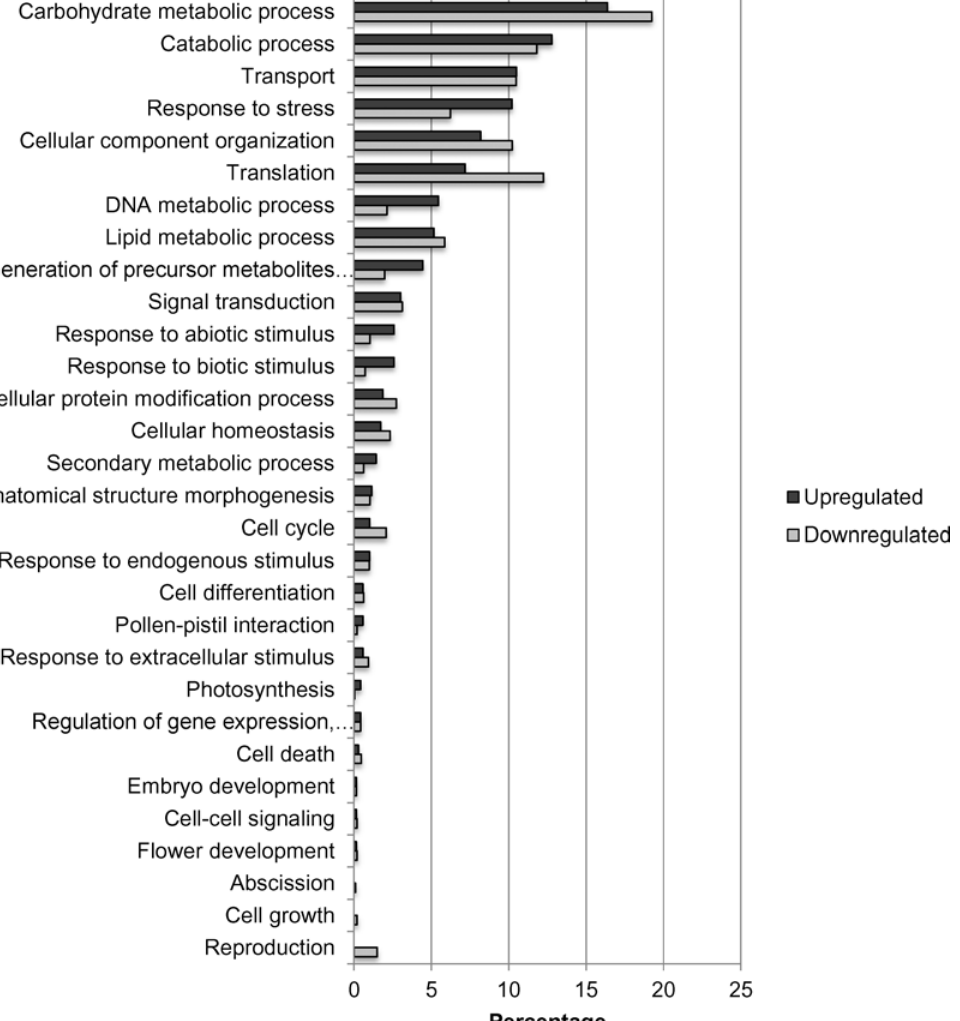
Fig 11. Percentage of upregulated (total number = 696) and downregulated (total number = 1,927) transcripts when nickel resistant Betula papyrifera genotypes were compared to nickel susceptible genotypes. Transcripts were assigned gene ontology and grouped by biological function using